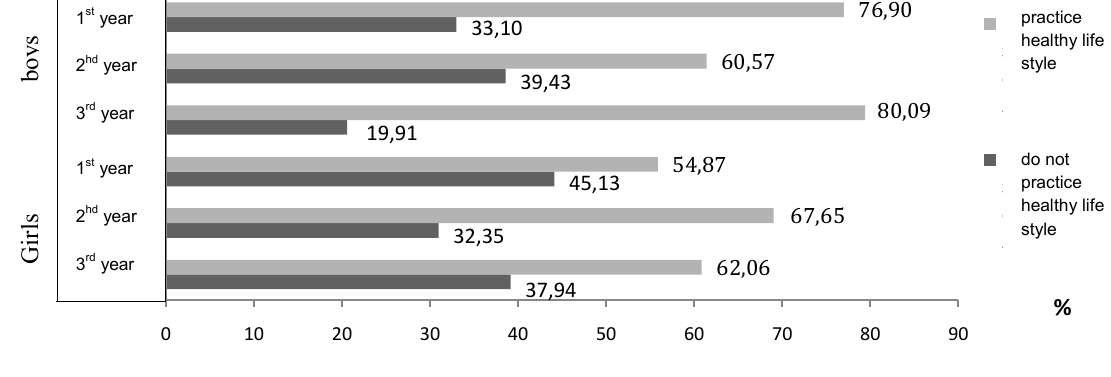
Fig.4. Self assessment of healthy life style by students of SRU “BelSU”